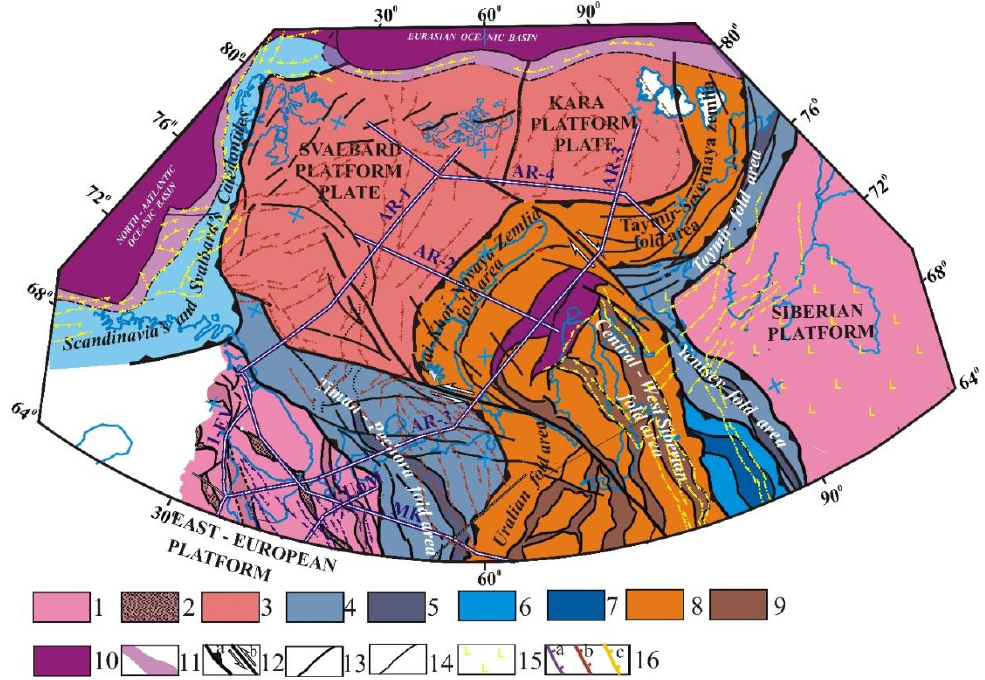
Figure 3. Scheme of tectonic zonation of the consolidated basement of the Eurasian sector of the Arctic. Numbers 1–11 are structural and material units of the Earth's crust: 1–2—ancient platforms